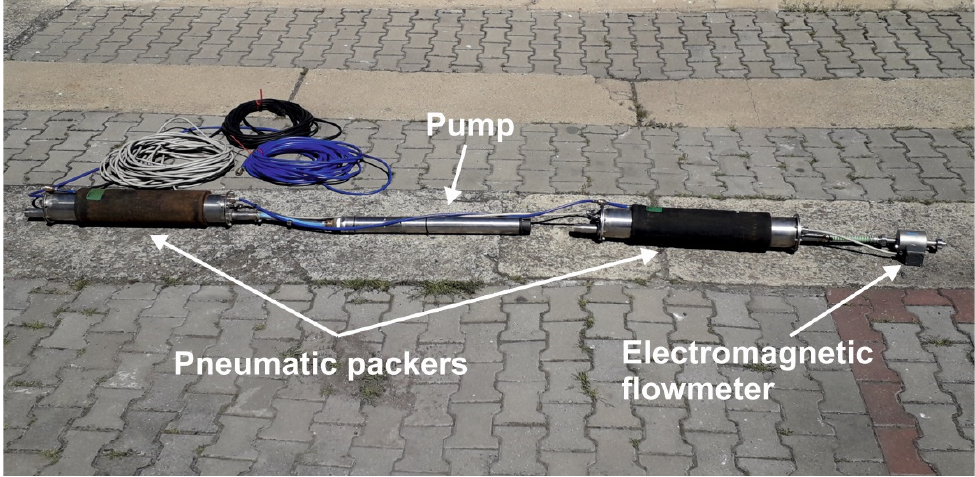
Figure 8. The constructed INV-FLOW apparatus used in the pilot tests.